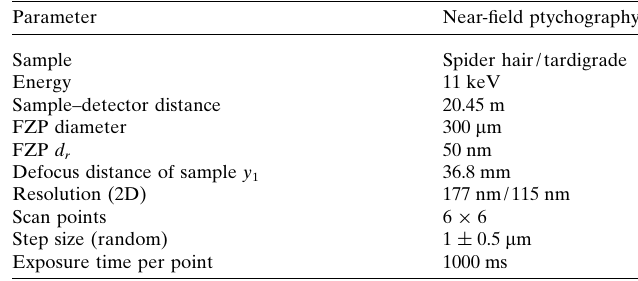
Table 3 Parameters of the near-field ptychography